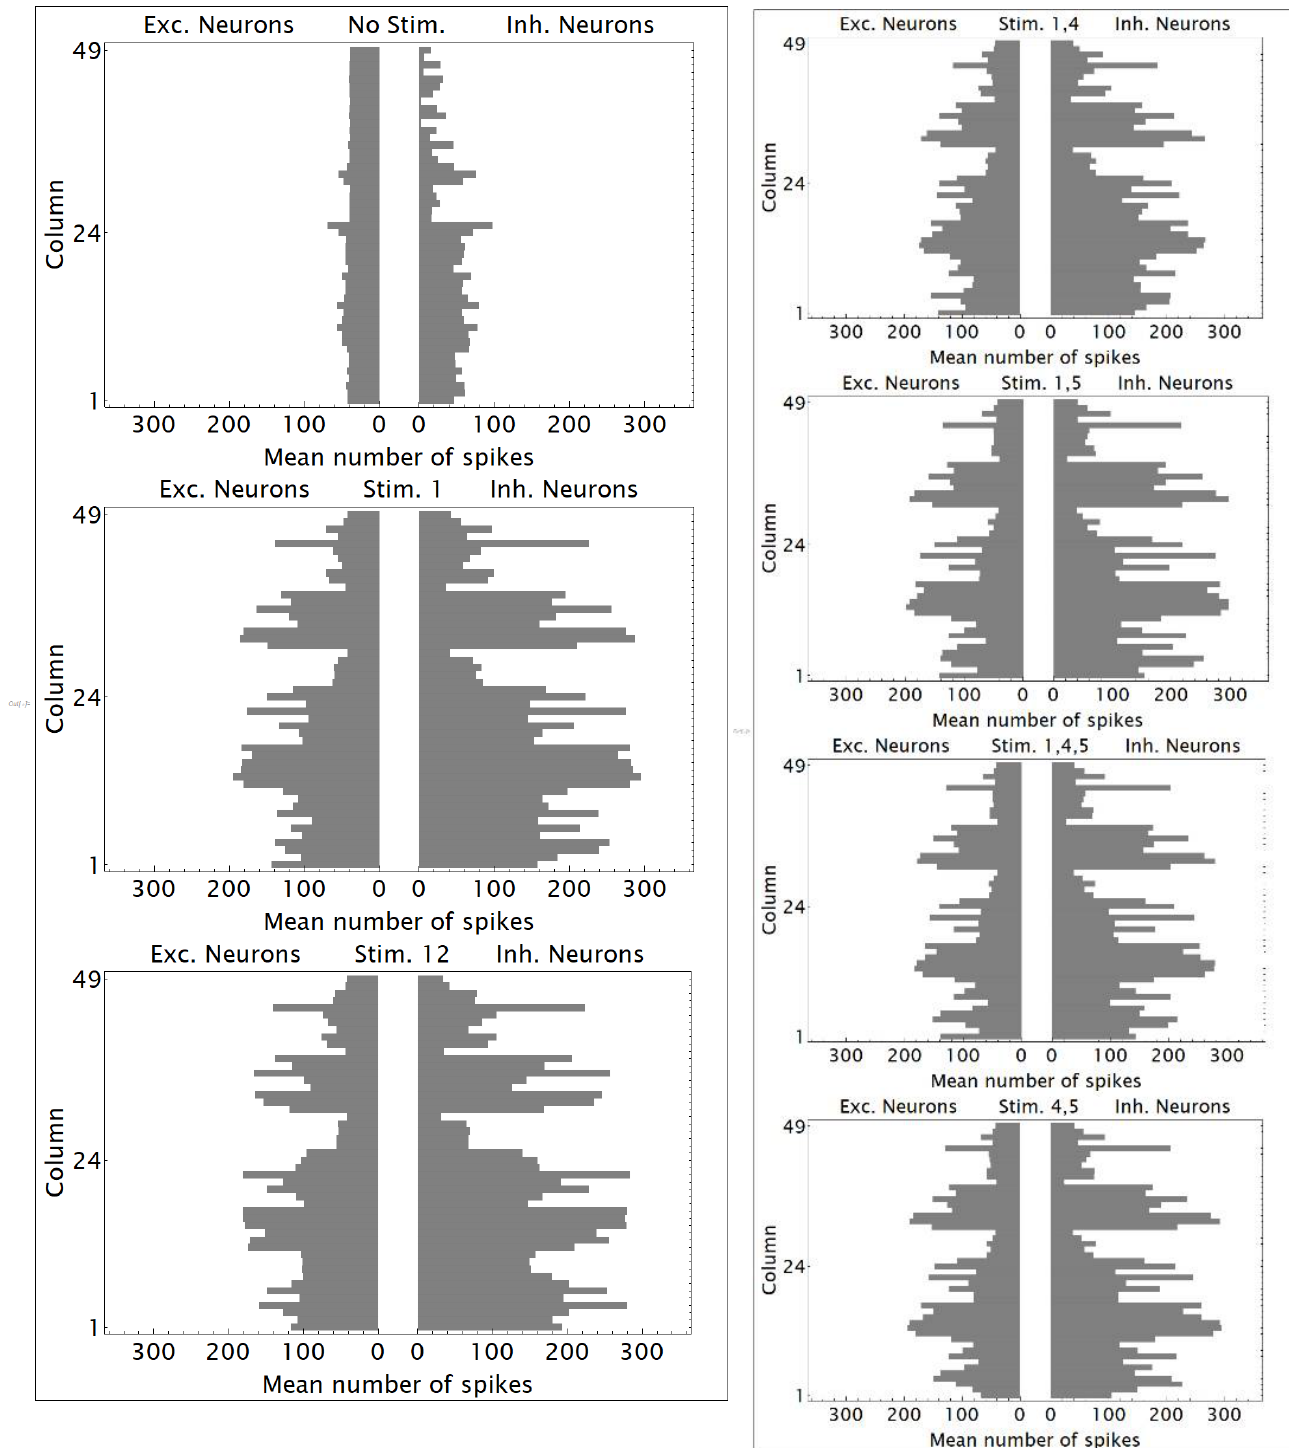
Figure 8. Examples of distributions of mean numbers of spikes produced by the neurons in each column during the first second of a 10 s simulation in which 40 excitatory spikes/s were delivered to excitatory network neurons. ( a ) There are clear differences between the distributions in ( a ) but those in ( b ) appear to be more similar and suggest that correct classification of the expected number of phosphenes would be difficult.